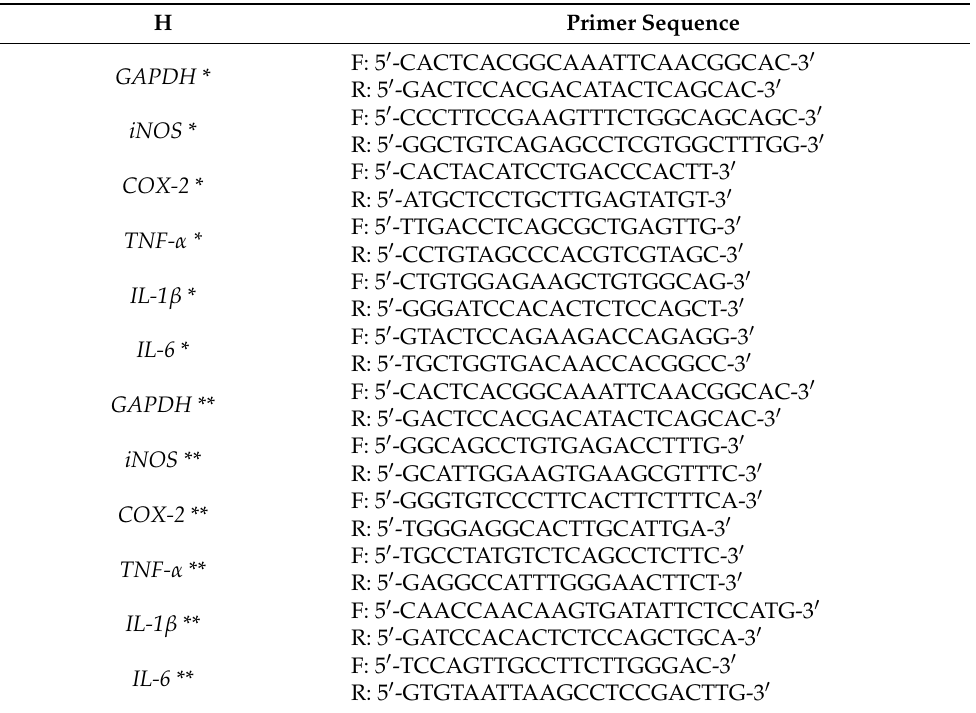
Table 1. Primers used for reverse transcription polymerase chain reaction (RT-PCR) and real-time PCR analysis in this